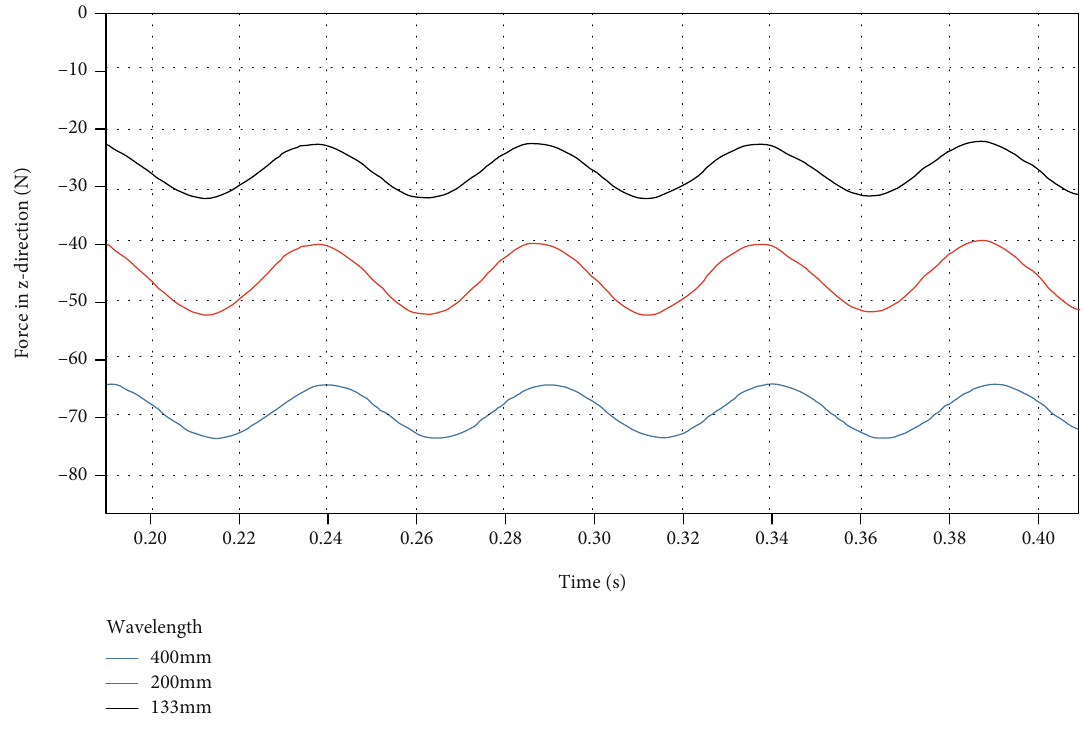
Figure 16: z -direction force on the dorsal fi n at di ff erent wavelengths. Table 9: z -direction force parameter values of the dorsal fi n at di ff erent